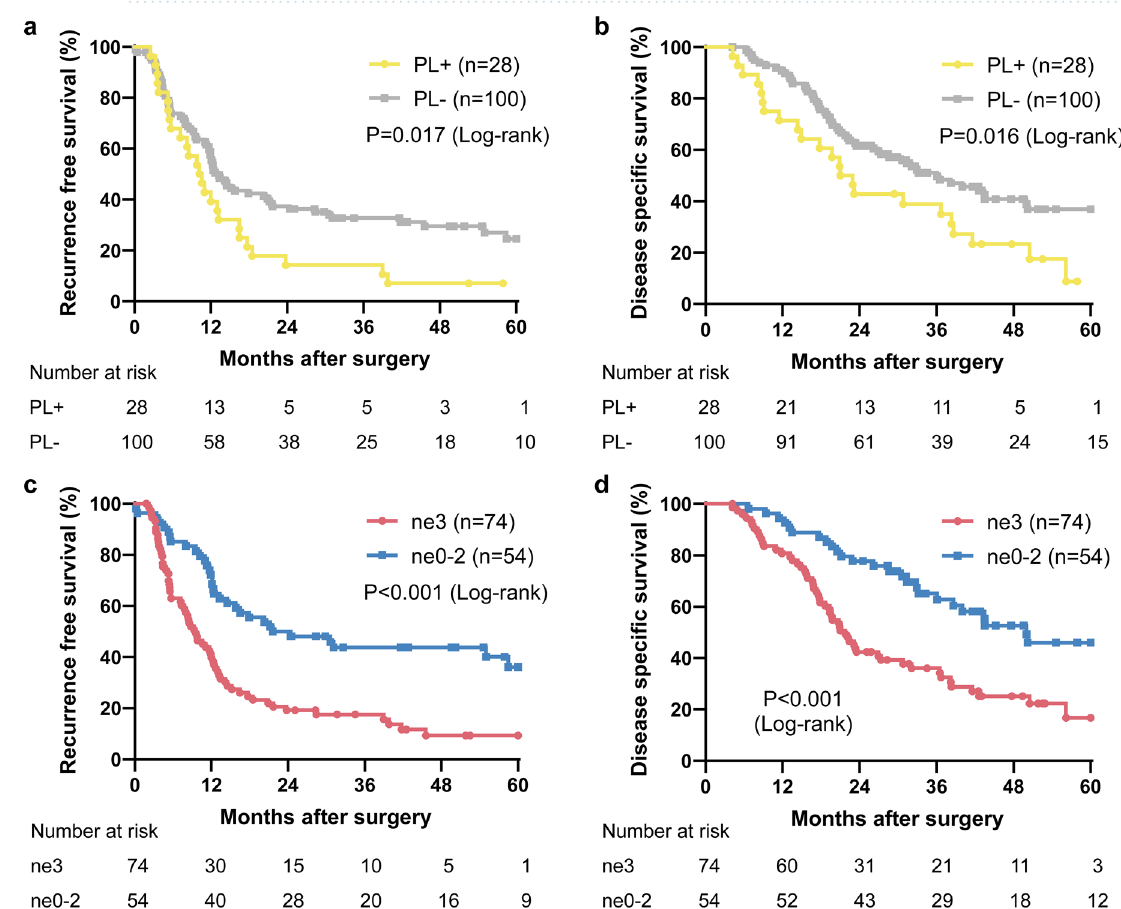
Figure 2. Survival analysis by log-rank test in the PL and non-PL groups, ( a ) Recurrence free survival (P = 0.017), ( b ) Disease specific survival (P = 0.016). Survival curves in the high-grade ne and low-grade ne groups, ( c ) Recurrence free survival (P < 0.001), ( d ) Disease specific survival (P < 0.001). ne nerve invasion, PL extrapancreatic nerve plexus